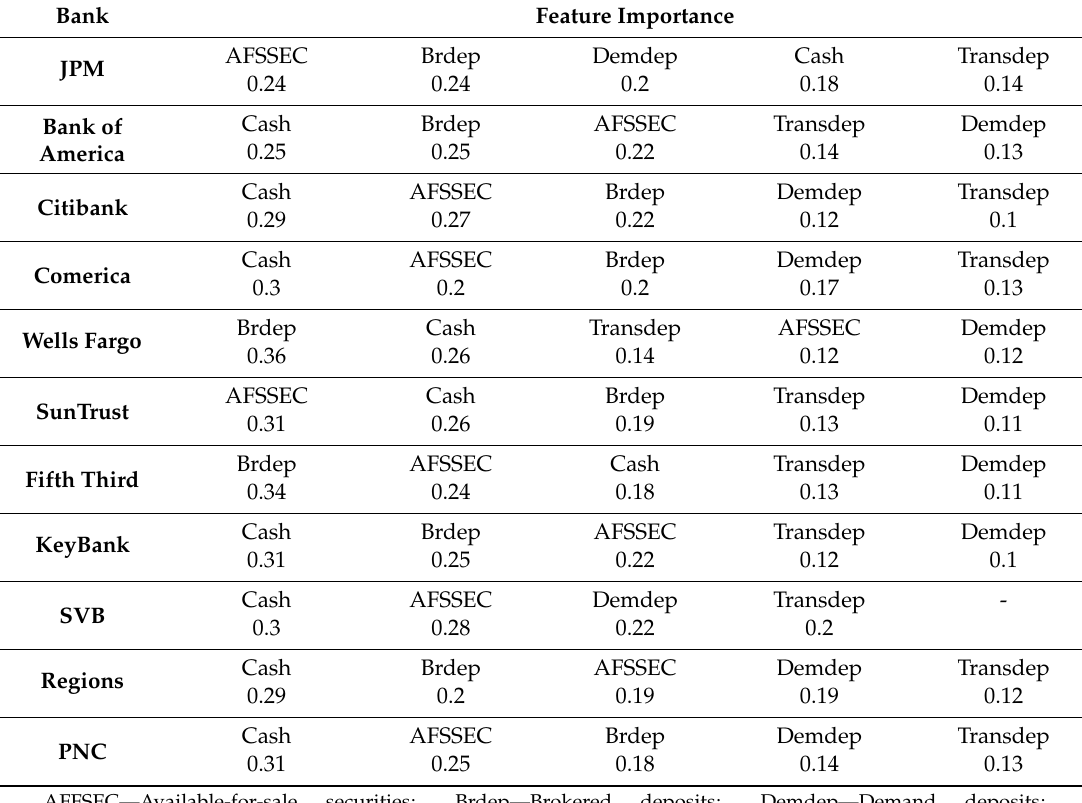
Table 1. Feature